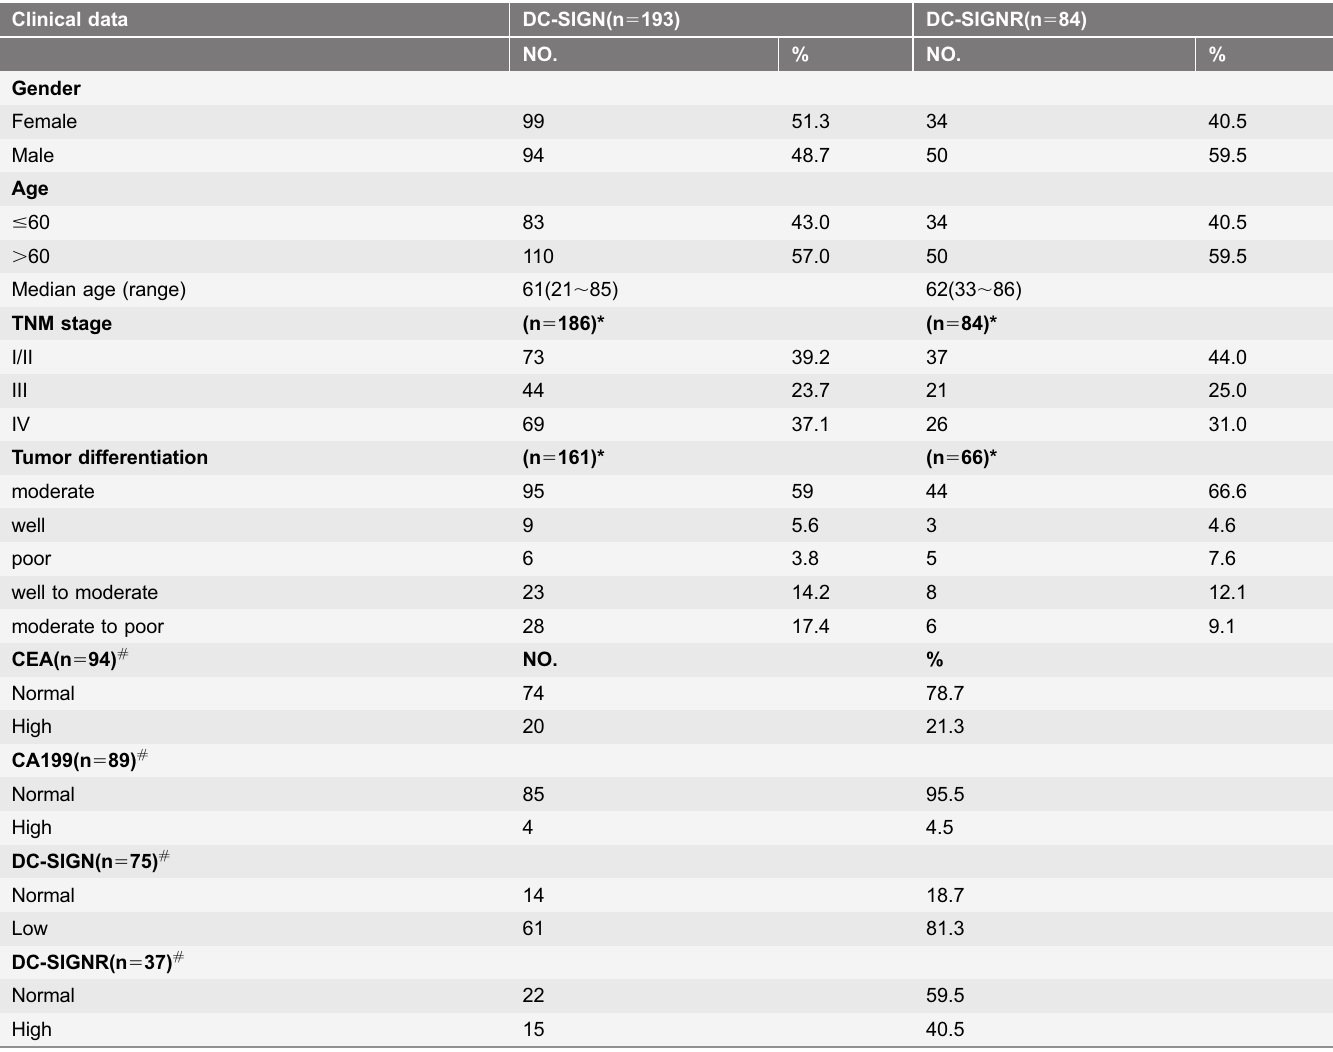
Table 1. Clinical data of the colon cancer patients in ELISA study and the diagnostic values of different novel markers in the colon cancer with early stage. Clinical data DC-SIGN(n 5 193) DC-SIGNR(n 5